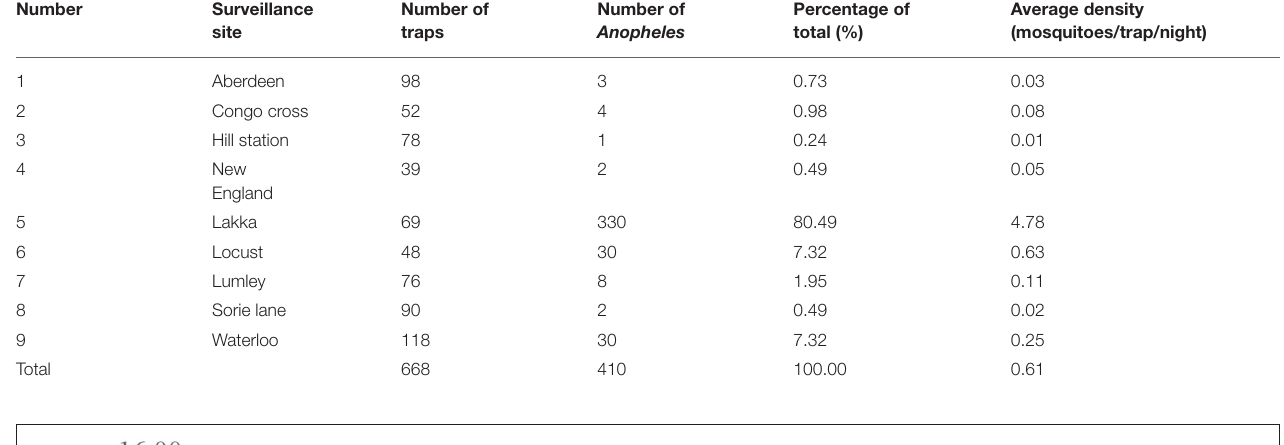
TABLE 3 | Trapping of Anopheles mosquitoes in different surveillance sites.